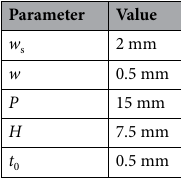
Table 1. The optimal dimensions of the proposed unit cell parameters.